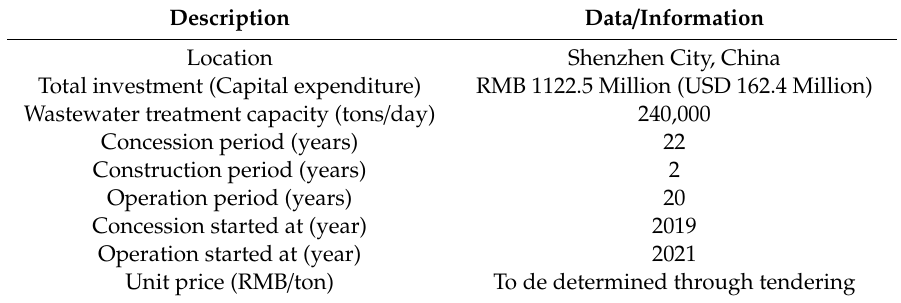
Table 5. Detailed information of Shenzhen Gushu Wastewater Treatment Plant (Phase